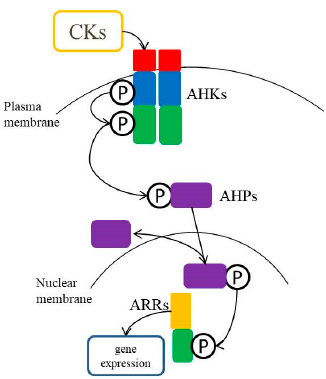
Figure 2. Diagram of the composition of the plant multi-step phosphorylation system.